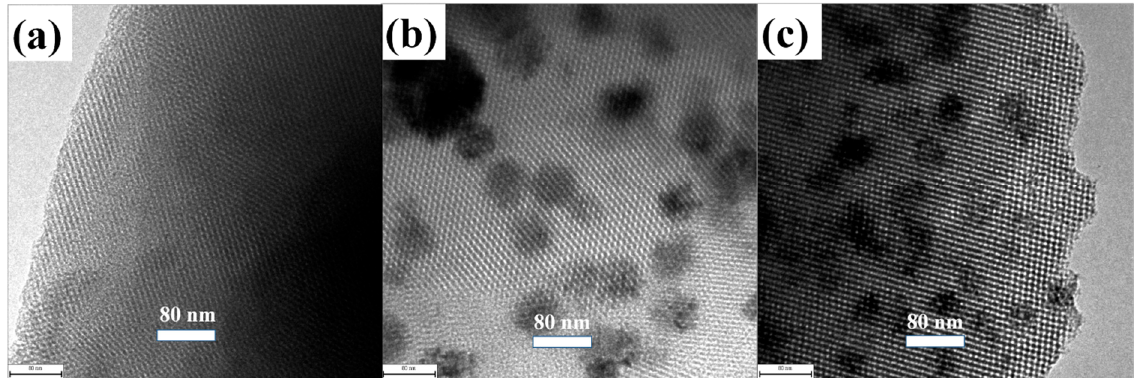
Figure 3. TEM images of ( a ) KIT-6, ( b ) fresh 10 wt% NiO/KIT-6 and ( c ) used 10 wt% NiO/KIT-6. Methane combustion took place on NiO/KIT-6 catalysts. Throughout the